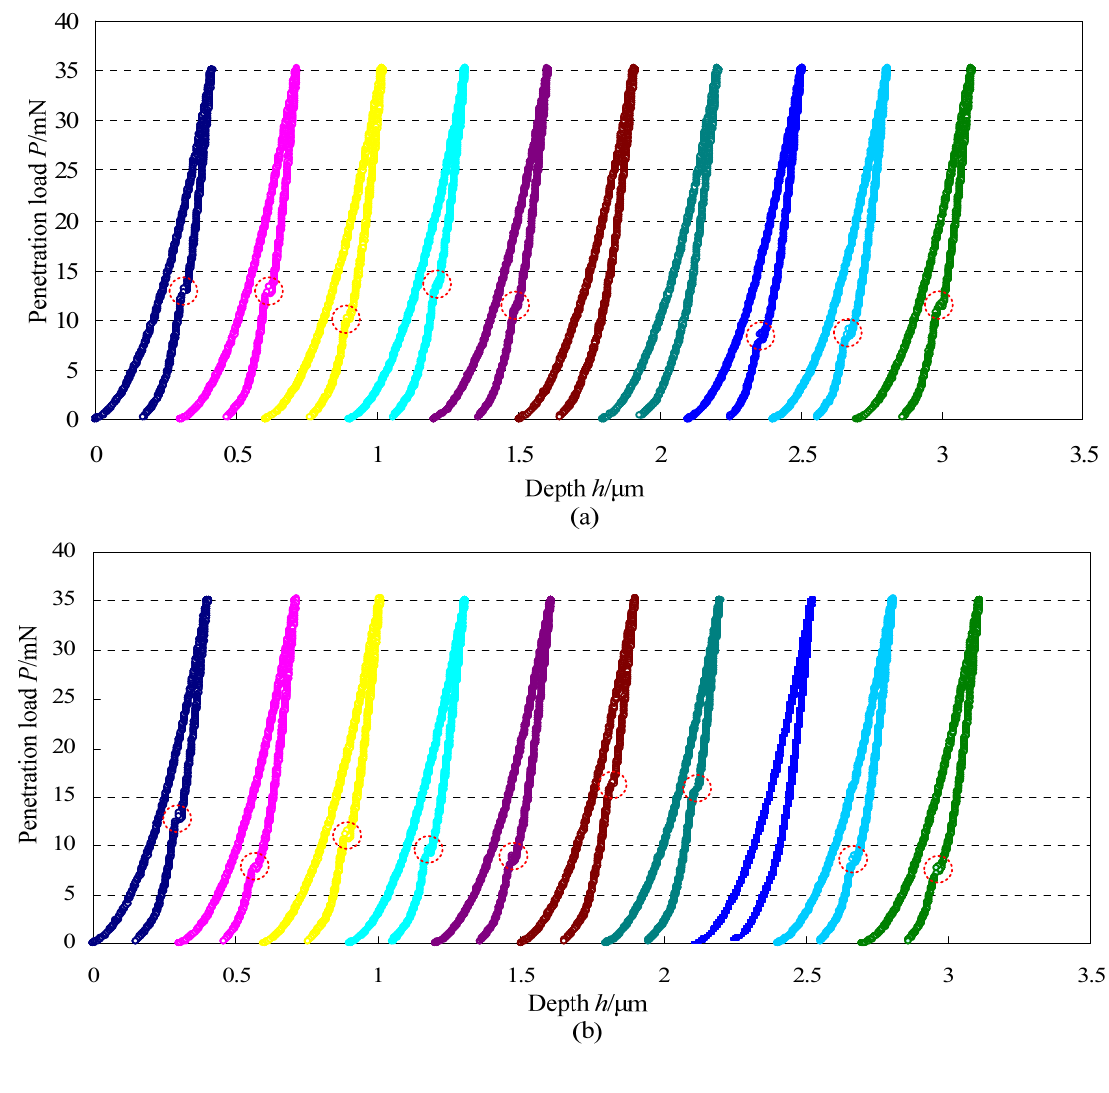
Figure 4. Load-depth curves of single crystal silicon with the same maximum penetration load of 35 mN and the same loading/unloading rate of 0.58